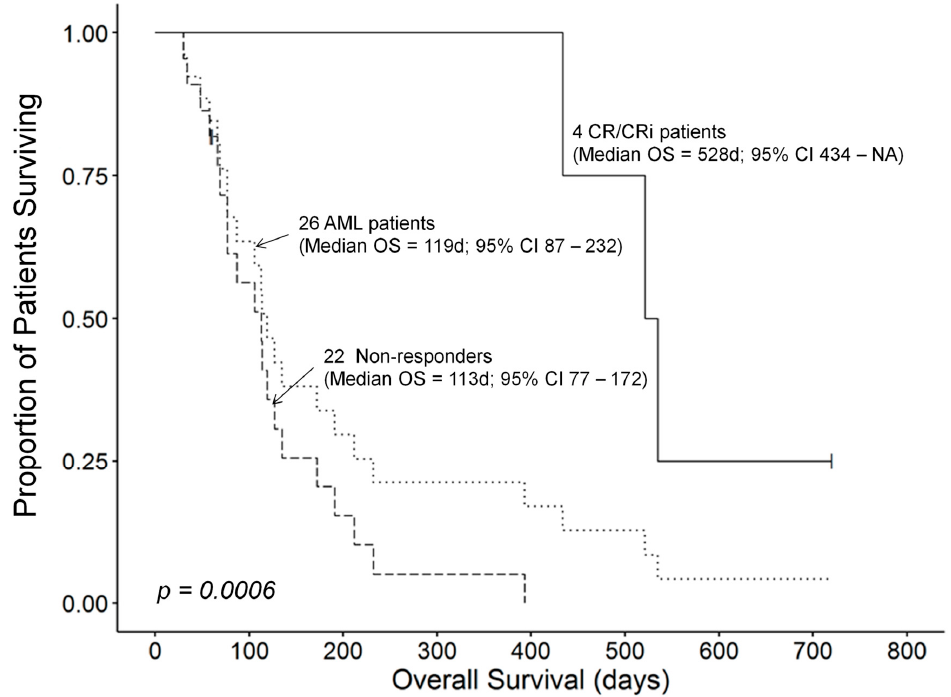
Figure 2. CR / CRi response to OXA is associated with improved survival outcome. The median OS time for 4 patients who achieved a CR or CRi was 528 (95% CI: 434–NA) days. By comparison, the median OS time was 113 (95% CI: 77–172) days for 22 patients who failed to achieve a CR or CRi. This difference in survival outcome was statistically significant (Log Rank χ 2 = 11.8, p -value = 0.0006). Notably, 3 of the 4 CR/CRi responses were achieved in older relapsed AML patients ≥ 65 years of age. One patient had treatment-related AML (tAML). Two of the 4 CR/CRi patients had 5q- with adverse cytogenetic features (co-occurring with either inv3 or 7q-), 1 had a normal karyotype, and 1 had inv16. Of note, 3 of the 4 CR/CRi patients had a low blast burden at initiation of OXA therapy, none had leukocytosis, and 2 had MDS-related cytogenetic abnormalities. None of the 5 MLL-R + patients (Patient ID#’s 107-002, 103-002, 101-002, 107-004, 103-013) responded to OXA; these patients died rapidly from disease progression with a median OS time of 28 days. 3. Discussion The greatest challenge in AML is relapsed or refractory ( R / R ) disease [2,7,8,11–16]. For R/R AML or MDS patients, there is no consensus on a single re-induction regimen. High allele frequencies of certain somatic mutations, such as in IDH1 or IDH2, may signal an opportunity for small molecule enzyme inhibitors. However, for the majority of R/R AML or MDS patients, guideline-directed standard of care suggests enrollment in a clinical trial or empiric use of one of the many cytotoxic re- induction regimens. Although progress has been made in understanding cell-intrinsic drivers of AML and new drugs have been developed for targeting select somatic mutations, the majority of relapsed AML patients die of leukemia [2,7,8,11–16,51–53]. In patients at second or third relapse, the median overall survival is approximately 3 months, warranting the identification of new molecular targets and development of novel therapies aimed at overcoming the drug resistance at relapse. OXA is a novel combination therapy that consists of investigational anti-AML drug OXi4503 and intermediate dose ARA-C. The primary goal of the present study was to evaluate the safety and tolerability of OXA in patients with R/R AML.